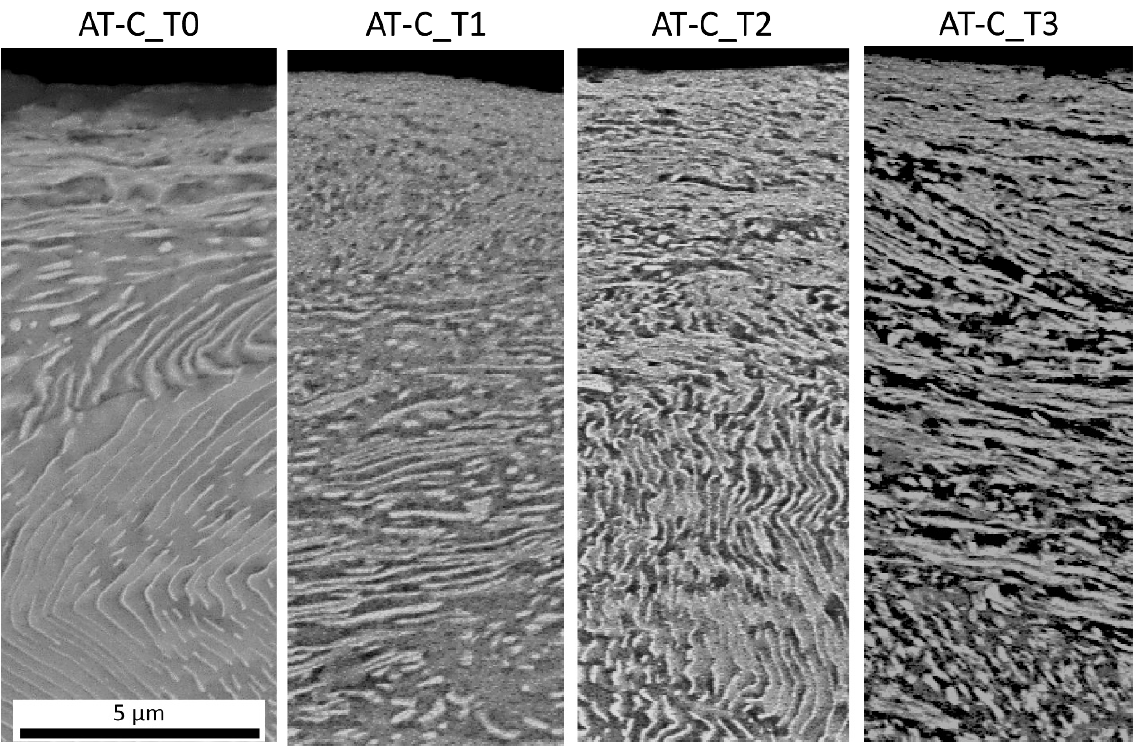
Figure 11. SEM images of the near-surface in the transverse direction, for all the tracks of Ring AT-